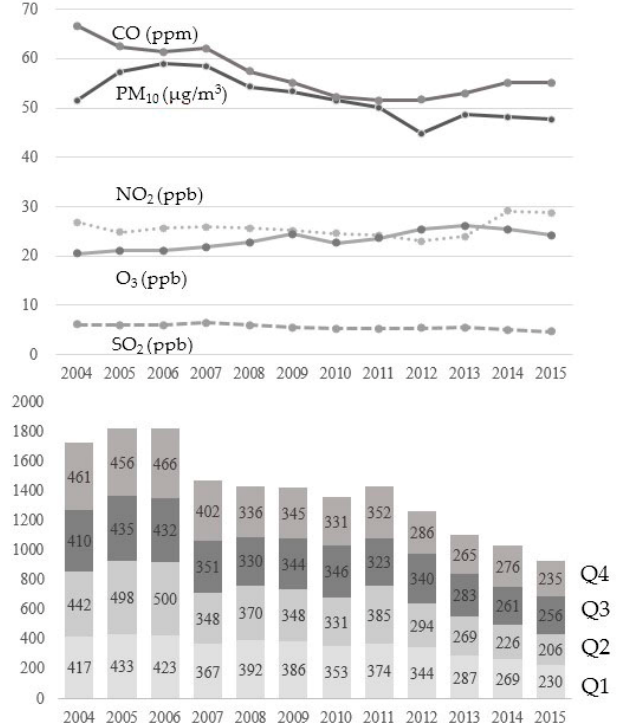
Figure 2. Trend in the levels of air pollution ( upper ) and the patients’ number of diagnosed cataract according to the quartile levels of PM 10 from 2004 to 2015 ( lower